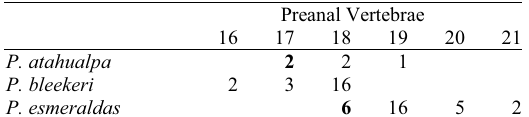
Table 26. Number of specimens of the species of Paracetopsis with cited number of preanal vertebrae. Bold indicates values for holotype when examined.